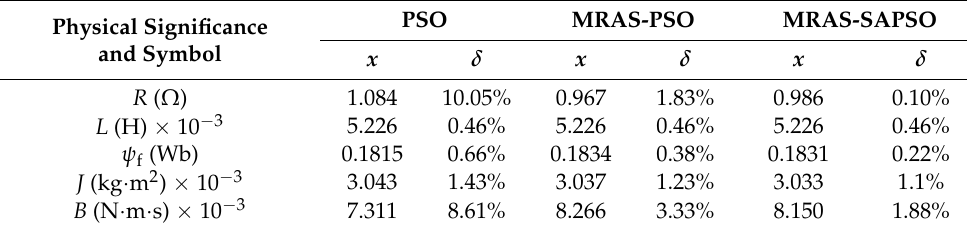
Table 2. Pulsation analysis results of pump-controlled motor system driven by a variable-frequency PMSM.